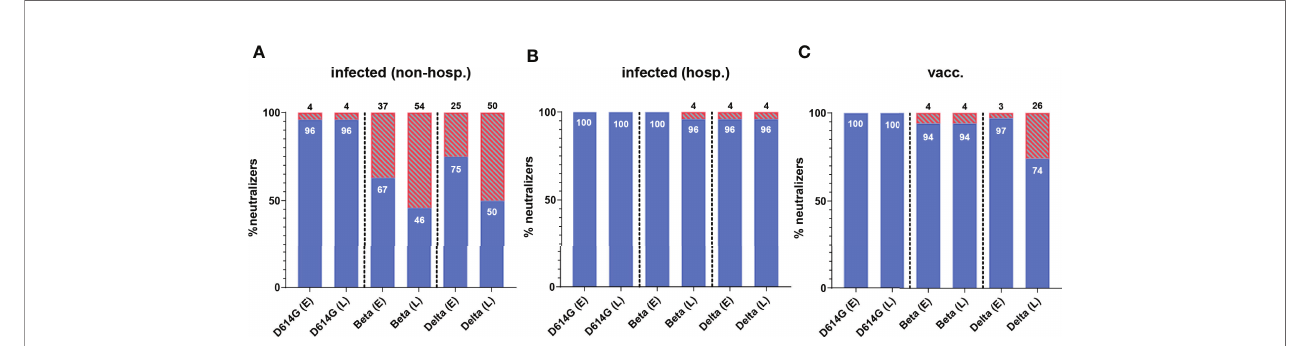
FIGURE 3 | Percentage of individuals with neutralizing activity against an ancestral D614G virus strain and the two VOCs Beta and Delta in (A) non-hospitalized and (B) hospitalized patients and (C) individuals after two doses of the mRNA vaccine BNT162b2. Early samples (E) were taken approximately three weeks after disease onset or the second vaccine dose; late samples (L) approximately six months after disease onset or the second vaccine dose. The percentage of serum samples with a positive (blue) and negative (red, lined) result for both time points are shown. Numbers in/on bars indicate the percentage of NT-positive and NT-negative individuals, respectively. non-hosp, non-hospitalized patients; hosp, hospitalized patients; vacc, vaccinees.